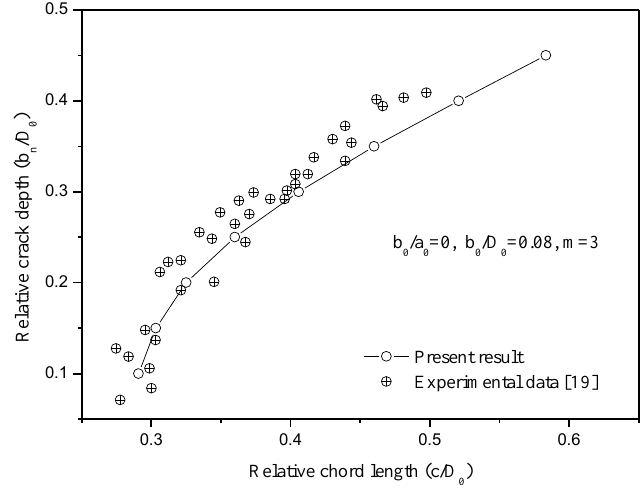
Figure 13. Relationship of crack propagation with depth and chord length compared with experimental data.